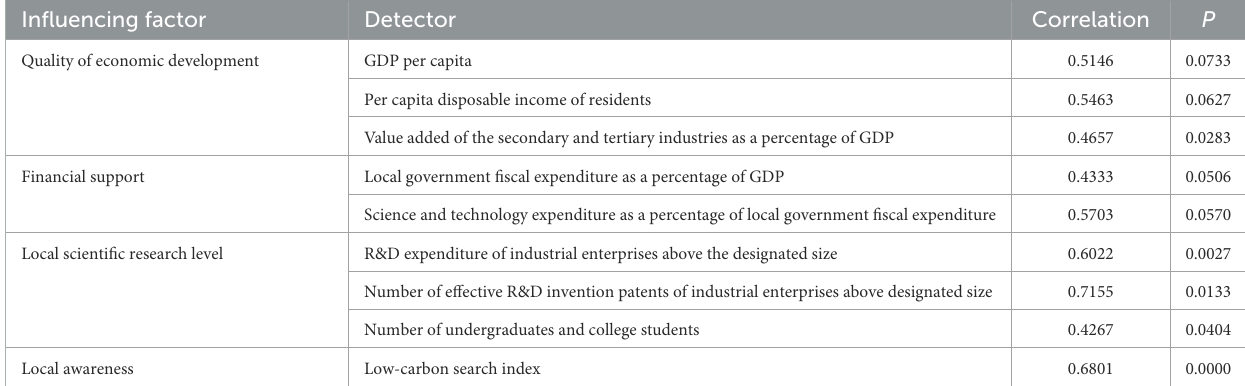
TABLE 10 Correlation coefficients between the weighted degree of the low-carbon patent cooperation network and influencing factors. Influencing factor